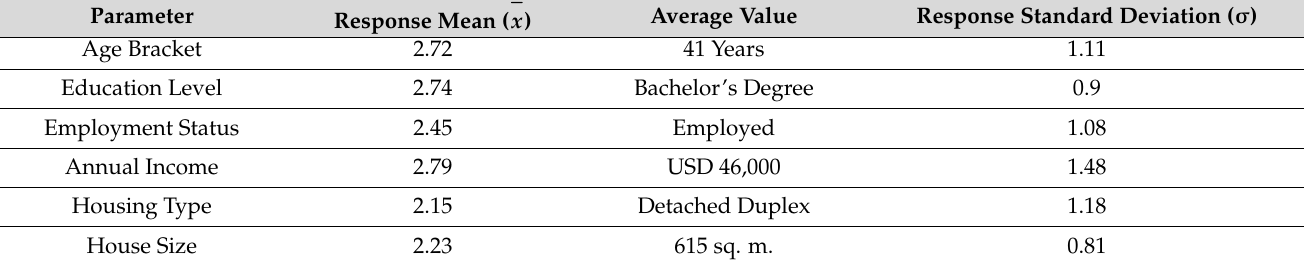
Table 3. Descriptive statistical analysis results.